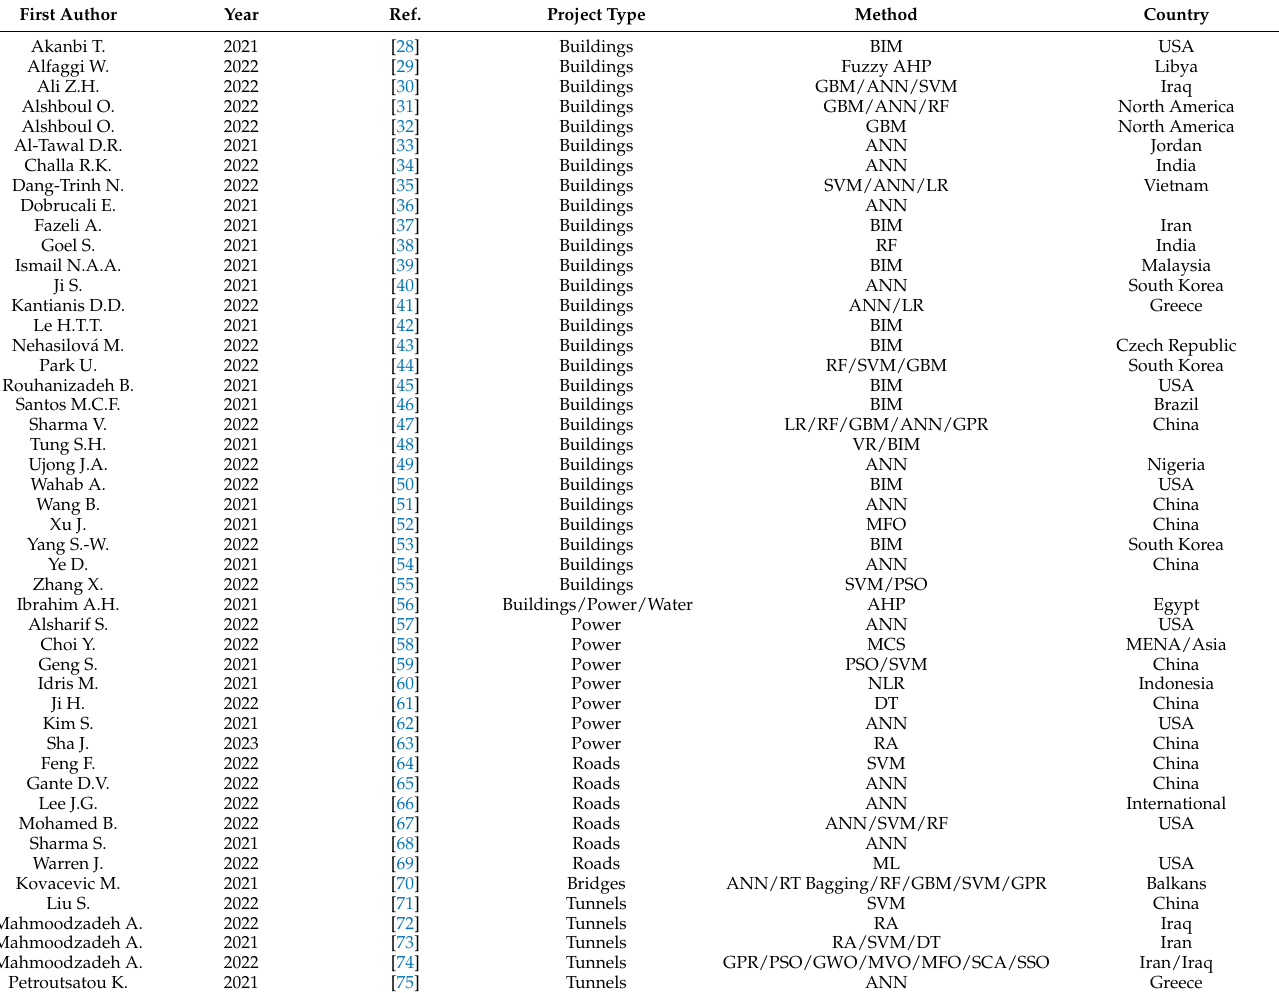
Table 1. Construction cost estimation research 2021 to 2022 per project type, method, and